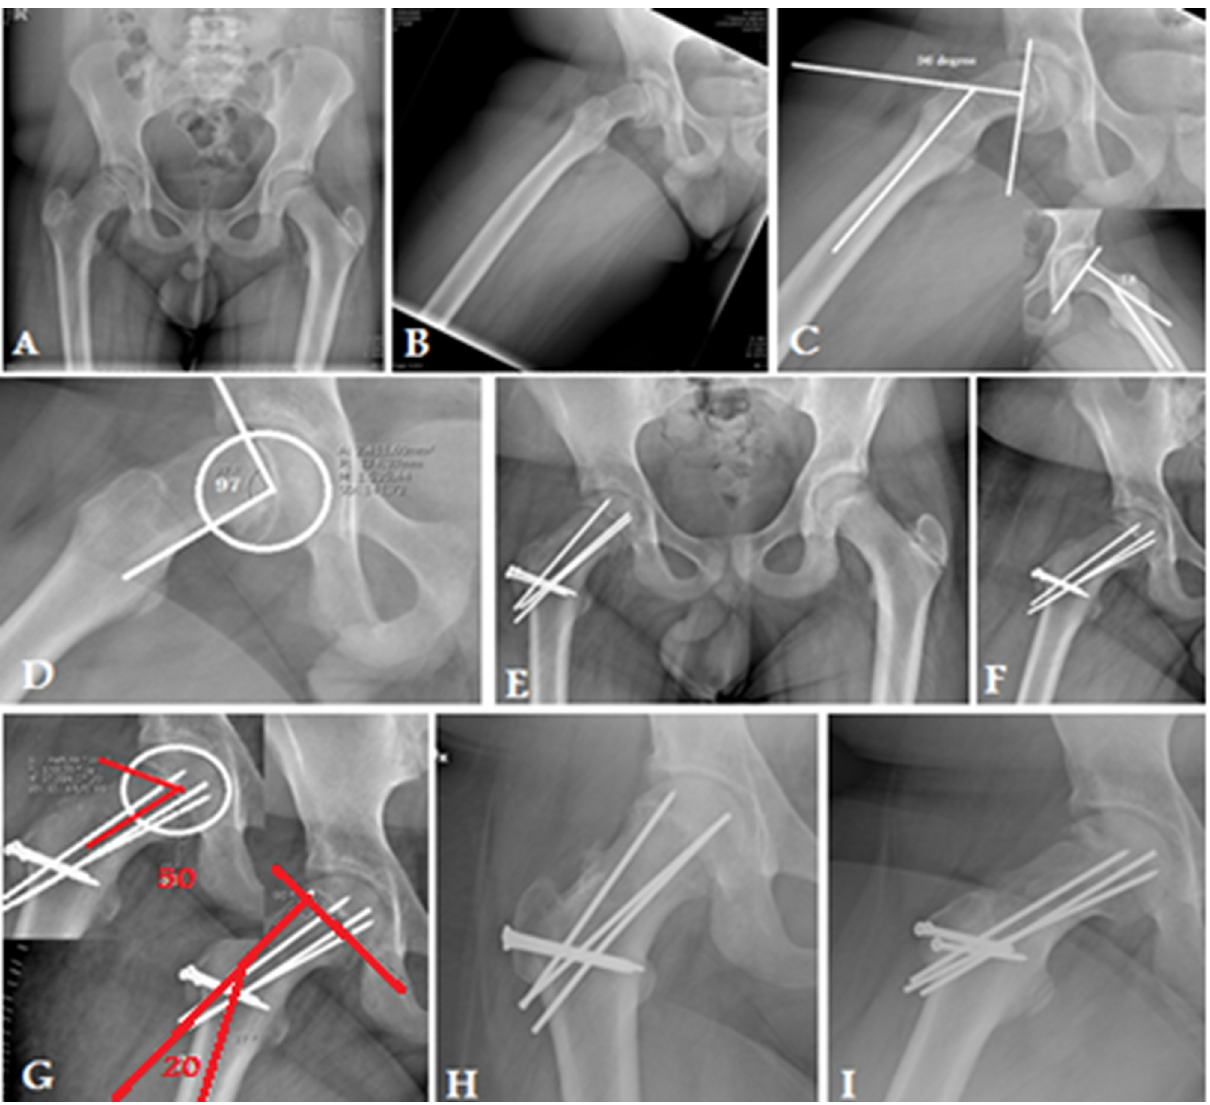
Figure 4. X-ray in a 15-year-old male with Rt chronic stable SCFE (case number 10): (A) preoperative AP pelvis, (B) preoperative frog lateral view of the Rt hip, (C) preoperative measurement of Southwick slip angle, (D) preoperative measurement of alpha angle, (E) and (F) postoperative anteroposterior (AP) and frog view, (G) postoperative measurement of Southwick slip and alpha angles, (H) 16-month postoperative AP and frog lateral X-ray showing complete union of trochanteric osteotomy and physis with no evidence of